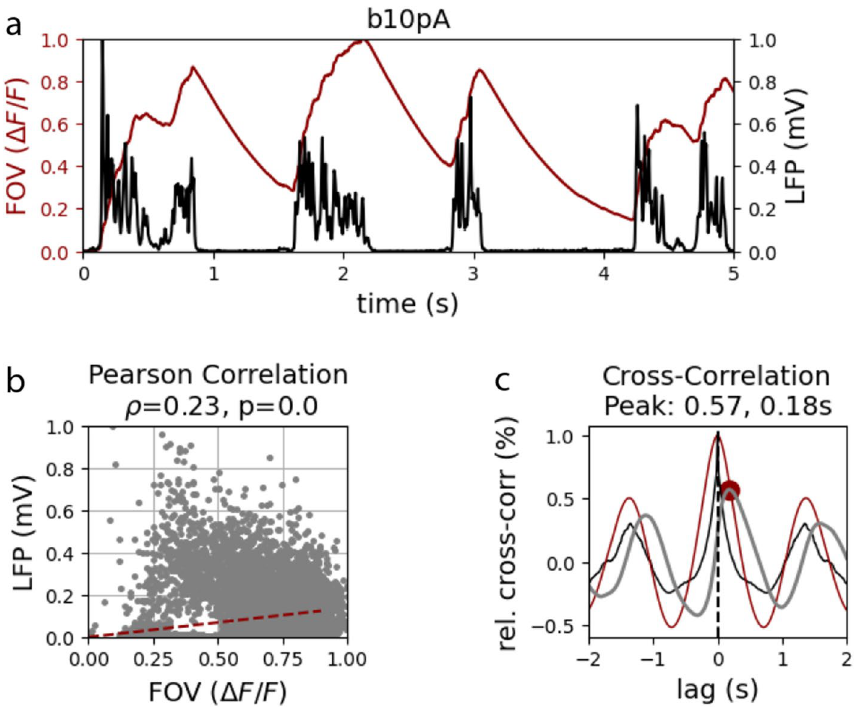
Figure 8. Correlation measures in the model. a. Simulated calcium and LFP normalized signals during 20 seconds of simulation at b = 10 pA (light anesthesia) in the centered condition. b. Pearson’s correlation. c. Auto- and cross-correlation of LFP (black trace) and calcium (red trace) signals. The cross-correlation (grey trace) peak is depicted with a red